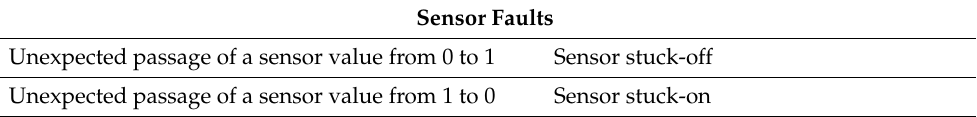
Table 1. Considerate faults.